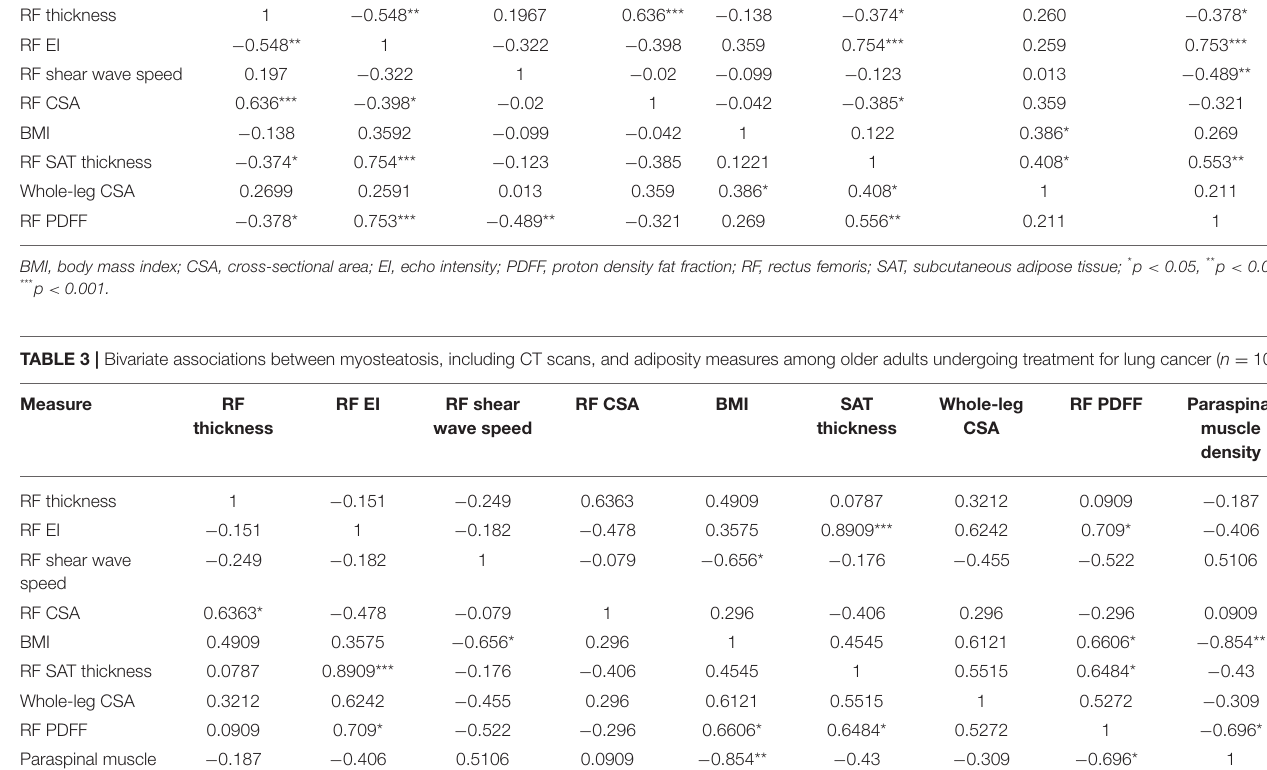
TABLE 2 | Bivariate associations between myosteatosis and adiposity measures among the entire sample ( n = 30). Measure RF thickness RF EI